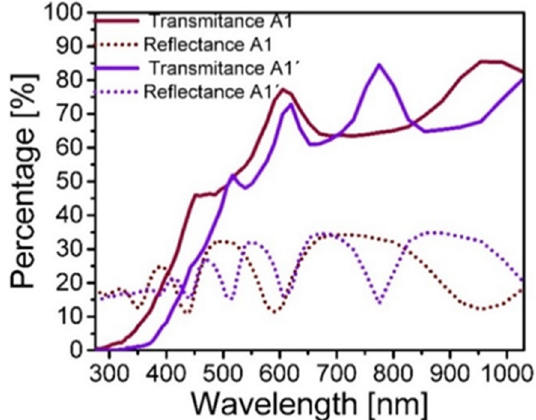
Figure 2. Reflectance and transmittance of the A1, A1’ SiO x films without (A1) and with thermal annealing (A1’).